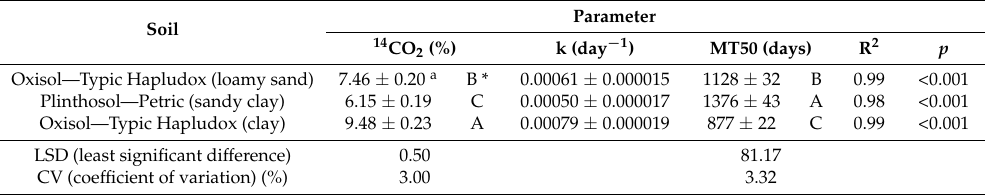
Table 3. 14 CO 2 accumulated at 126 days of incubation (%) and parameters of the first order kinetics (k and MT50) based on 14 CO 2 released until 126 days of incubation of three tropical soils applied with 14